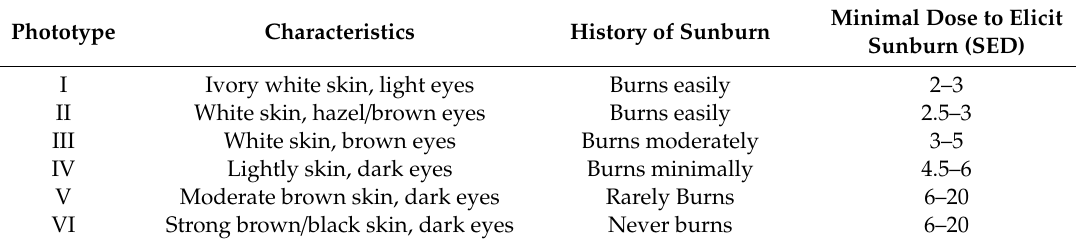
Table 1. Skin phototype classification